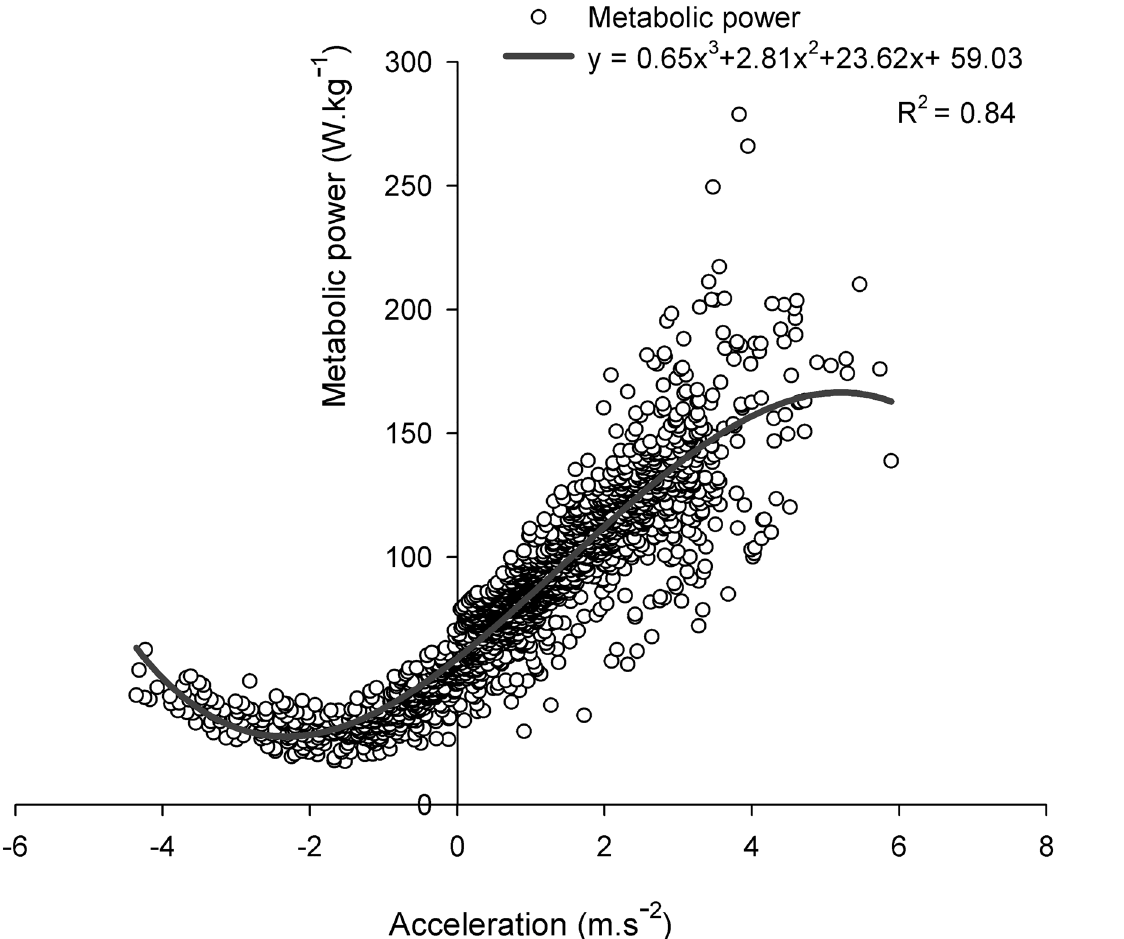
Fig 3. Relationship between acceleration and metabolic